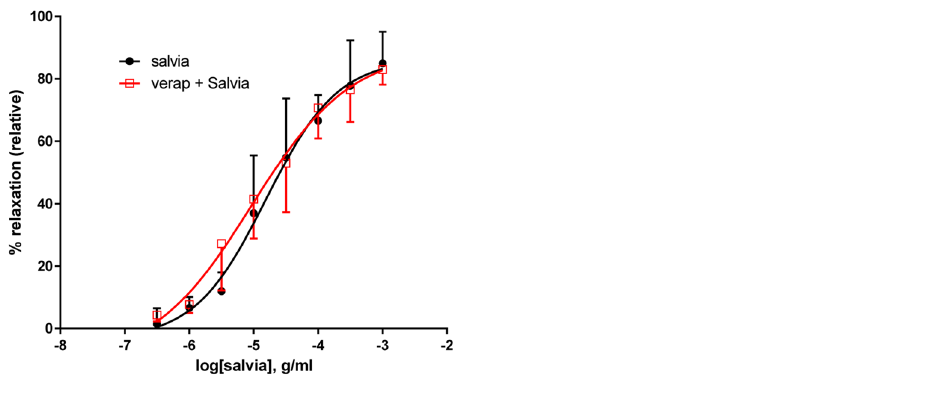
Figure 8. Role of Calcium Channels in SF-induced relaxation of aortic rings. Endothelium-intact rings were incubated with cumulative doses of SF in the absence (Salvia; circles) or presence of verapamil (1 µ M; verap + Salvia; squares). n = 5; p >